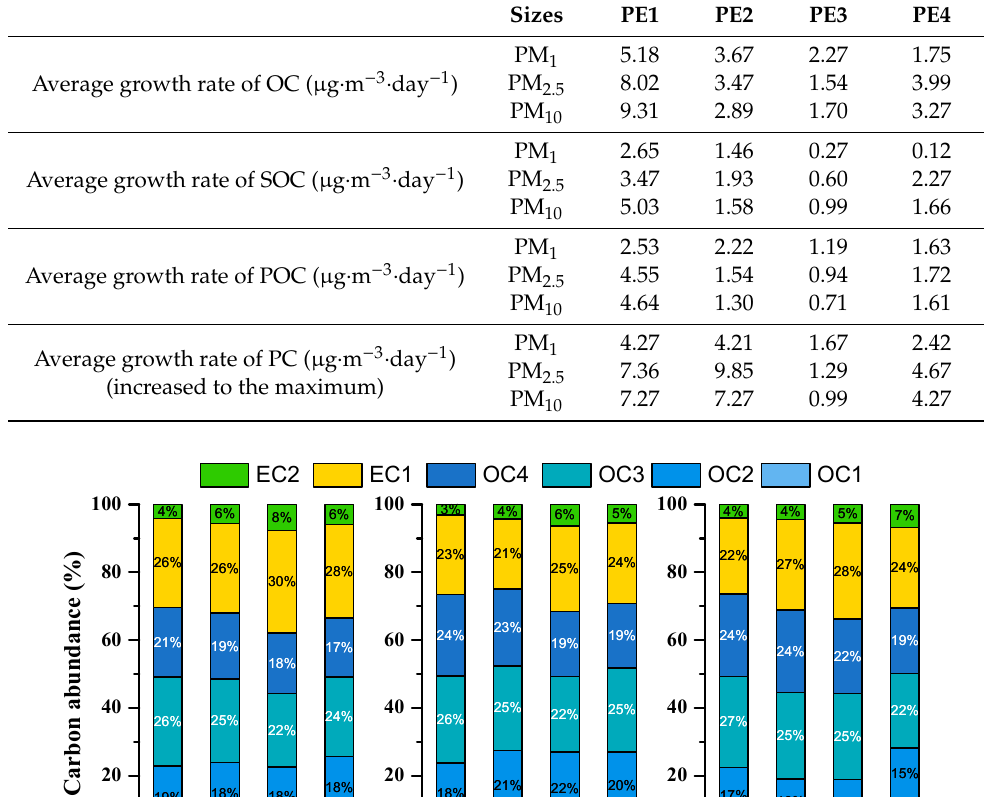
Table 3. The growth rate of OC, SOC, POC and PC of PM 1 , PM 2.5 and PM 10 in 4 PEs. Sizes PE1 PE2